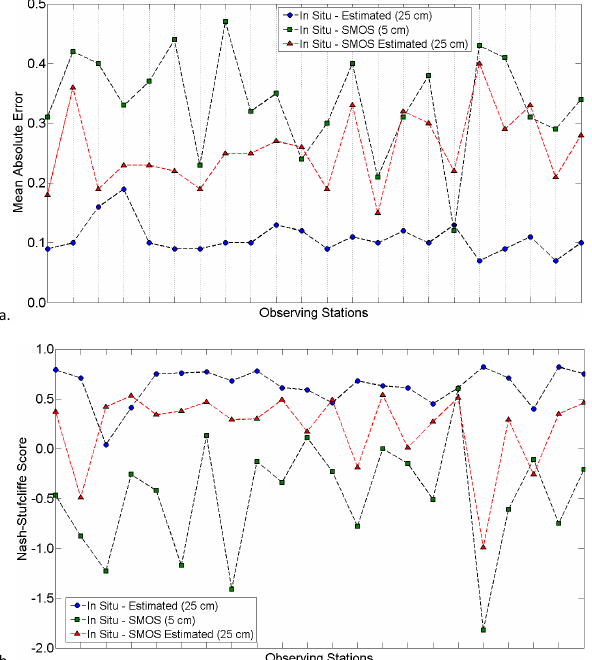
Figure 15 . The top plot shows MAE (SWI) at all Nebraska stations. MAE is calculated between (blue circles) in situ surface observations and in situ root zone estimates, (green squares) in situ near-surface observations and SMOS surface retrievals and (red triangles) in situ root zone observations and SMOS root zone estimates. The bottom plot shows NS scores at all Nebraska stations for the same dataset comparisons as in the top plot.